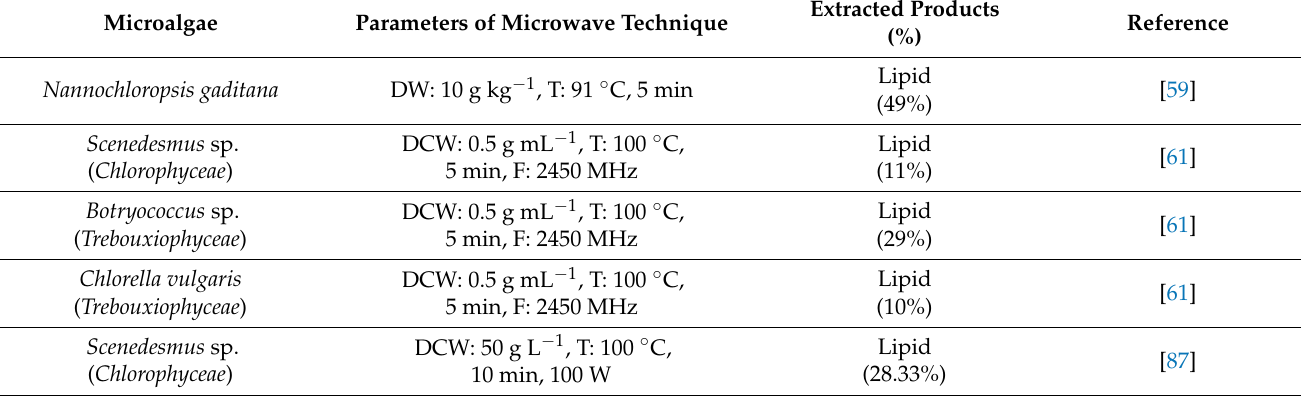
Table 2. Effects of the parameters of the microwave irradiation technique for the cell disruption of various types of microalgae. DCW: dry cell weight; DW: dry weight; WB: wet biomass; F: